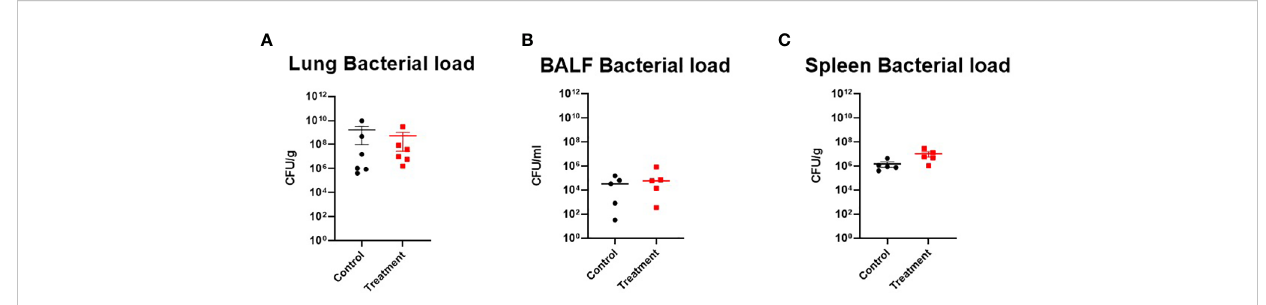
FIGURE 6 Bacterial clearance assay. (A) Lung bacterial load ● Control (n=6), ■ Treatment (n=6), (B) BALF bacterial load ● Control (n=5), ■ Treatment (n=5), (C) Spleen bacterial load ● Control (n=5), ■ Treatment (n=5). There was no signi fi cant difference between the groups in the bacterial clearance assay. Data are expressed as mean ±